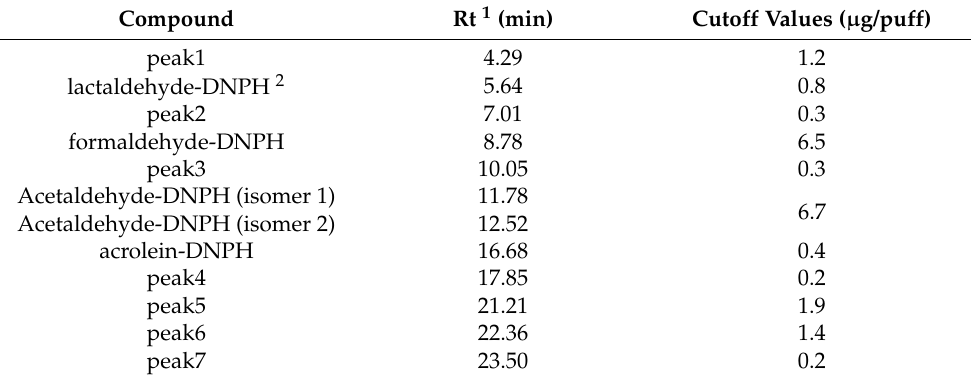
Table 1. Retention times (Rt) of the 11 “dry puff markers” (using WHO TobLabNet SOP08 [36].) and the highest amounts measured for liquid/coil/power settings combinations categorized as “no dry puff flavor” based on the results of the human assessors (“cutoff values”). Peaks corresponding to these compounds were identified in the chromatographic data by matching the retention time listed here to the retention time of peaks in the chromatogram. The concentration of each compounds was taken to be proportional to its peak surface area. Quantities in µ g were derived from the surface areas using formaldehyde-DNPH as a